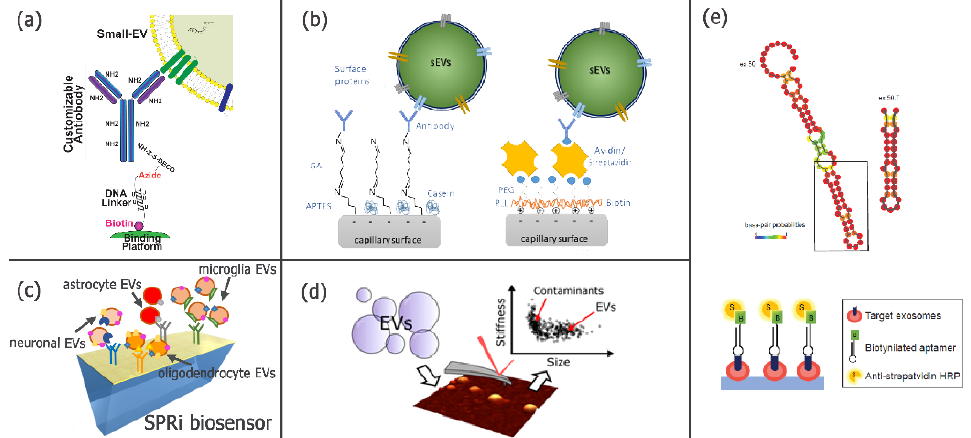
Figure 2. ( a ) Schematic representation of the EV-CATCHER strategy [29] developed for selectively purifying small-EVs from human biofluids. The assay relies on the binding of a degradable dsDNA- linker to a DBCO-activated antibody and to a streptavidin-coated platform. ( b ) Schematic diagrams of the APTES-GA and PPB-avidin/streptavidin functionalization method where a capillary surface is coated with a self-assembled monolayer of APTES or a layer of a PLL-PEG copolymer conjugated with biotin, which are then linked to the capture antibody. This experimental setup was used in electrokinetic measurements [30] (adapted with permission from [30]. Copyright: American Chemical Society, 2021). ( c ) Schematic representation of an SPRi-based biosensor for the isolation and simultaneous characterization of multiple EV subpopulations from liquid biopsies [31]. ( d ) Simple Atomic Force Microscopy (AFM)-based experimental procedure for the simultaneous nanomechanical and morphological analysis of EVs. The platform can be used to discriminate between subpopulations of vesicular and non-vesicular objects in the same sample [32] (adapted with permission from [32]. Copyright: American Chemical Society, 2020). ( e ) Secondary structure prediction of ex-50 aptamer and its shortened version (ex-50.T). In the ELONA-based detection system, plates are coated with EVs and incubated with biotinylated aptamers; signals are detected with streptavidin-HRP [33]. Another efficient platform for the isolation of high pure EVs, presented by Dr.